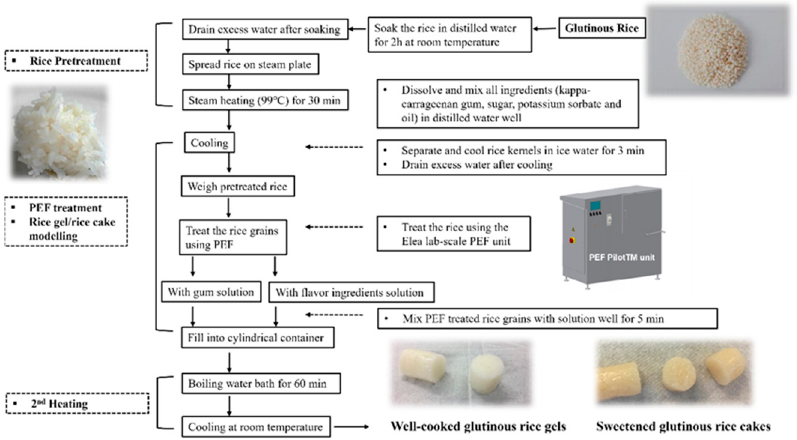
Figure 1. Schematic flowchart for the preparation of rice gel samples and rice cake samples made from glutinous rice grains with or without PEF treatment.